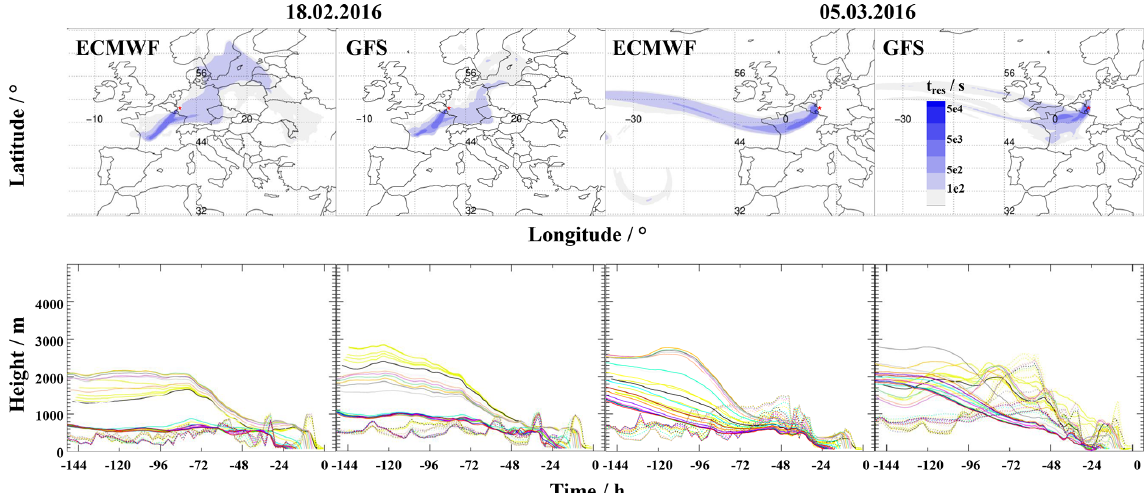
Figure 1. Simulated retro plumes (top; for the colour code, see legend) as well as centroid back-trajectory (bottom, solid lines) and the corresponding mixing-layer heights (bottom, dashed lines) for each release hour, using the ECMWF and GFS meteorology, exemplarily presented for the 18 February (left) and 5 March 2016 (right) samples. The FLEXPART analyses are done for the EIFE site (red star).